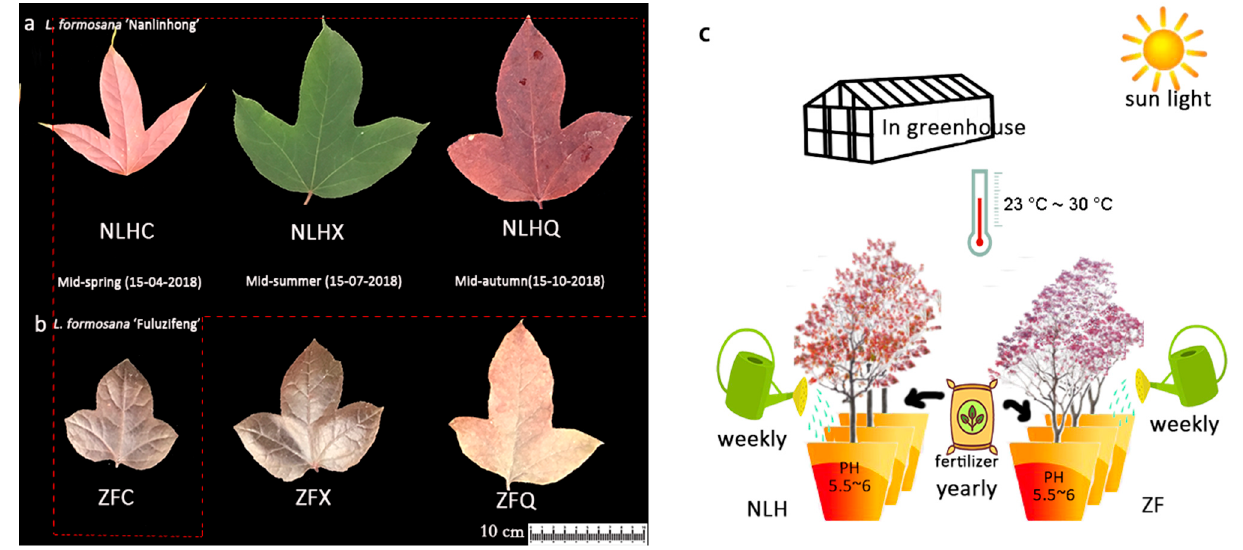
Figure 1. Different developmental stages of two varieties of L. formosana . ( a ): L. formosana ‘Nan- linhong’; ( b ): L. formosana ‘Fuluzifeng’; Four samples in the red box were used for transcriptome and metabolome detection. ( c ): Experiment design. During the growing season, 0.061 g/100 mL imidaclo- prid (Essence Co., Ltd., Nanjing, China) was used for pest control every three months (after sam- pling); plants were manually irrigated without herbicide and were watered once per week; organic fertilizer (Jing Longyuan Technology Co., ltd., Beijing, China) was only used in the fall of each year, and there was no shading or fill-up.